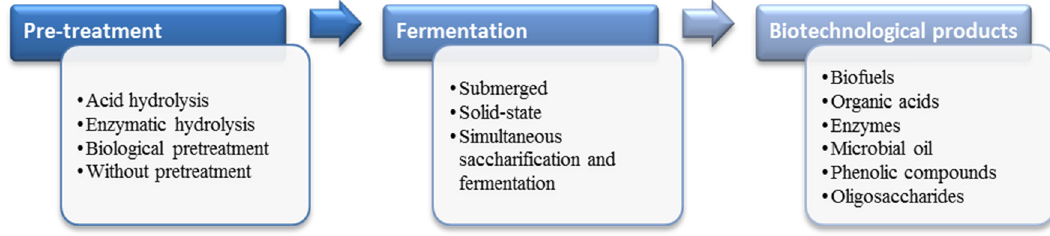
Figure 4. Conversion steps of DRB into biotechnological Figure 4 Conversion steps of DRB into biotechnological products.